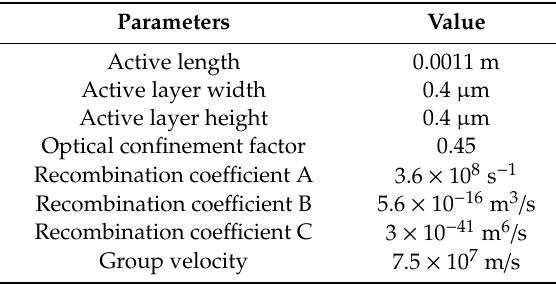
Table 1. Parameters chosen for the simulation of the semiconductor optical amplifier